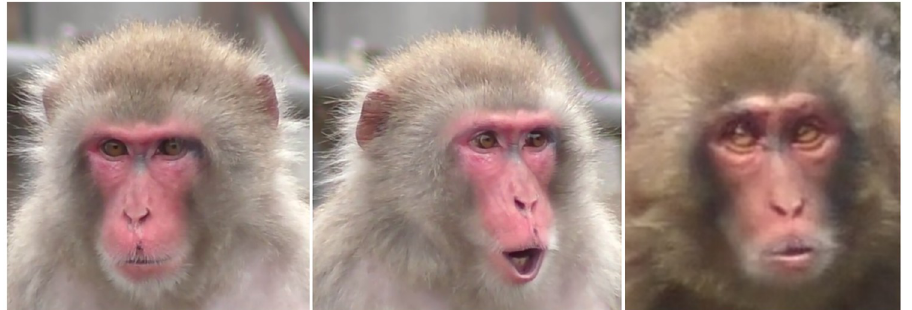
Fig 15. Left: Neutral; Centre: AU18i during vocalization (+AU16); Right: AU18ii.